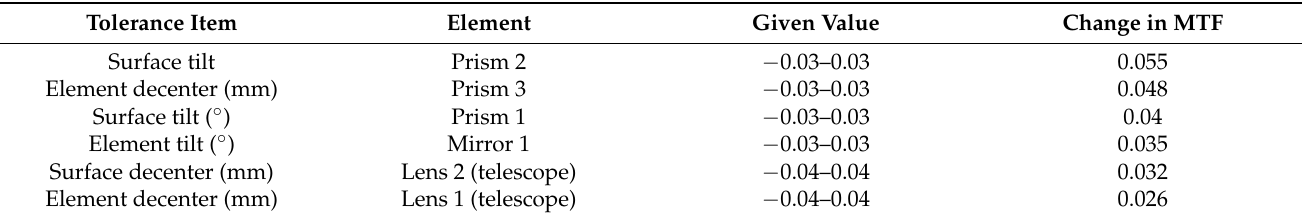
Table 2. Sensitive terms influencing the system in the tolerance analysis.